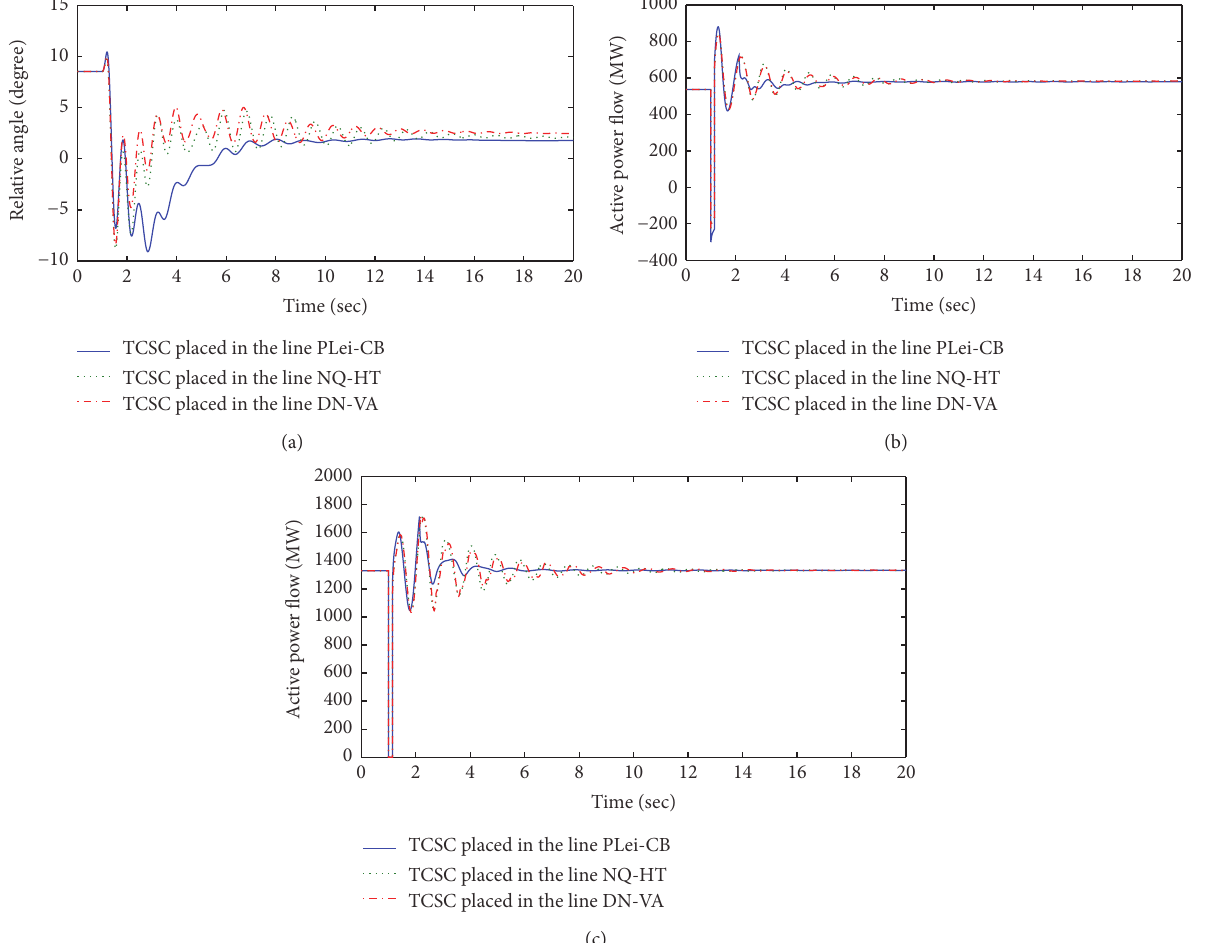
Figure 10: The transient response: (a) the relative angle oscillations of generator VinhTan; (b) the active power oscillations in the line CauBong-DucHoa; (c) the active power oscillations in the line Pleilu-ThanhMy.